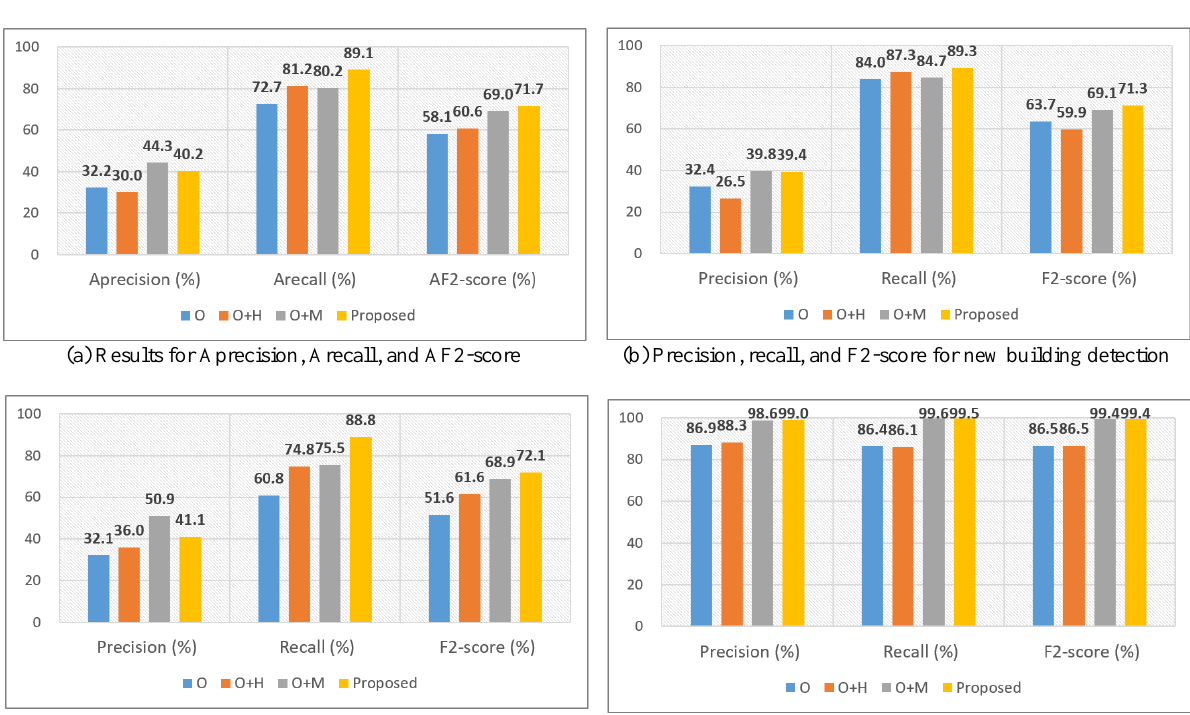
Figure 2. Quantitative results for the different